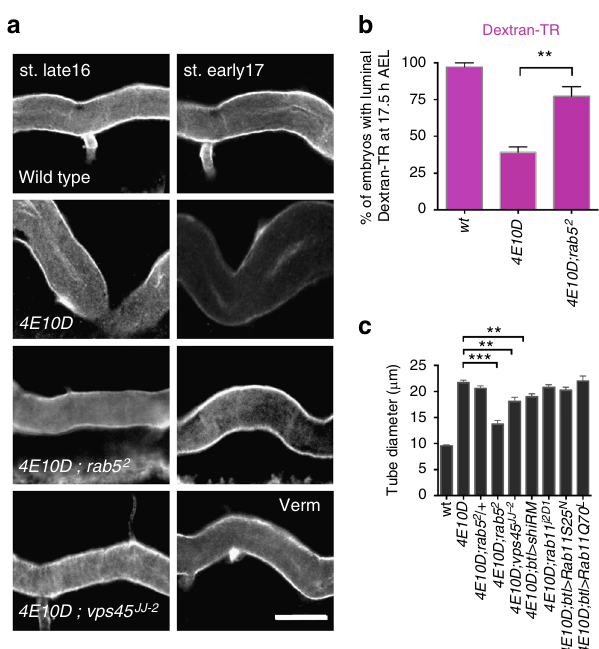
Fig. 2 Reduction of endocytosis restores the Ptp4EPtp10D phenotypes. a Confocal images displaying the dorsal trunk (DT) of late-stage 16 (left column) and early-stage 17 (right column) wild-type, Ptp4EPtp10D , Ptp4EPtp10D;rab5 2 and Ptp4EPtp10D;vps45 JJ − 2 embryos stained for the luminal protein Verm (grey). Scale bars, 10 μ m. b Plots showing the average number of wild-type ( n = 24), Ptp4EPtp10D ( n = 66) and Ptp4EPtp10D; rab5 2 ( n = 59) mutant embryos with luminal Dextran-TR at 17.5 h after egg laying (1.5 h prior to the luminal clearance initiation in wild type). The premature luminal clearance phenotype of Ptp4EPtp10D is suppressed in Ptp4EPtp10D;rab5 2 triple mutant embryos. ** P < 0.001. c Plots depicting the average DT (Tr8) diameter in wild-type ( n = 38), Ptp4EPtp10D ( n = 45), Ptp4EPtp10D;rab5 2 / + ( n = 28), Ptp4EPtp10D;rab5 2 ( n = 56), Ptp4EPtp10D; vps45 JJ − 2 ( n = 29), Ptp4EPtp10D;btl>Shi RM ( n = 37), Ptp4EPtp10D;rab11 j2D1 ( n = 22), Ptp4EPtp10D;btl>Rab11 S25N ( n = 47) and Ptp4EPtp10D; btl>Rab11 Q70L ( n = 27) embryos. The DT diameter phenotype observed in Ptp4EPtp10D mutants is signi fi cantly restored in Ptp4EPtp10D;rab5 2 , Ptp4EPtp10D;vps45 JJ − 2 and Ptp4EPtp10D;btl>Shi RM embryos. *** P < 0.001; ** P < 0.005. Unpaired two tailed t tests were performed in relation to Ptp4EPtp10D mutant data set ( b , c ). Error bars show s.e.m. (Supplementary Fig. 2c) arguing for an enrichment of acidic endosomal compartments in Ptp4EPtp10D at the time of premature protein clearance. In addition, staining with an antibody that recognizes mono- and poly-ubiquitylated proteins (FK2) showed decreased accumulation of degradation-targeted